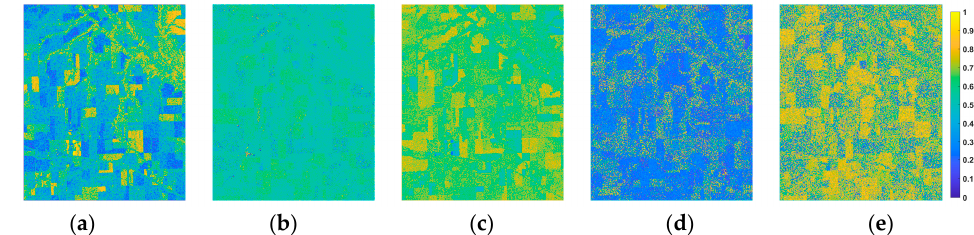
Figure 8. Some typical features: ( a ) amplitude of HH-VV correlation, ( b ) phase difference of HH-VV, ( c ) co-polarized ratio, ( d ) null angle parameters— θ _Re [ T 12 ] , and ( e ) null angle parameters— θ _Im [ T 12 ] . H: horizontal polarization, V: vertical